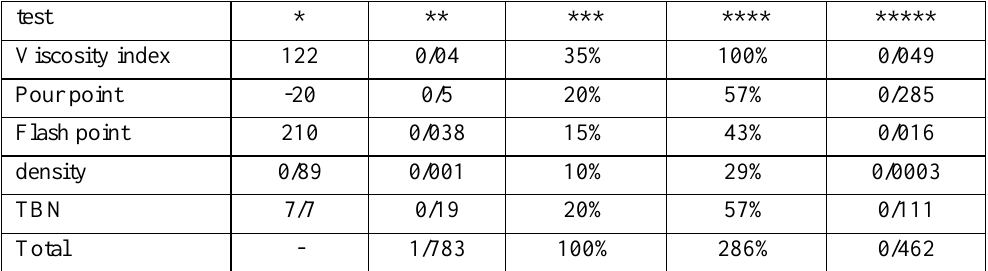
Table1. The results of Nano-oil technical efficiency